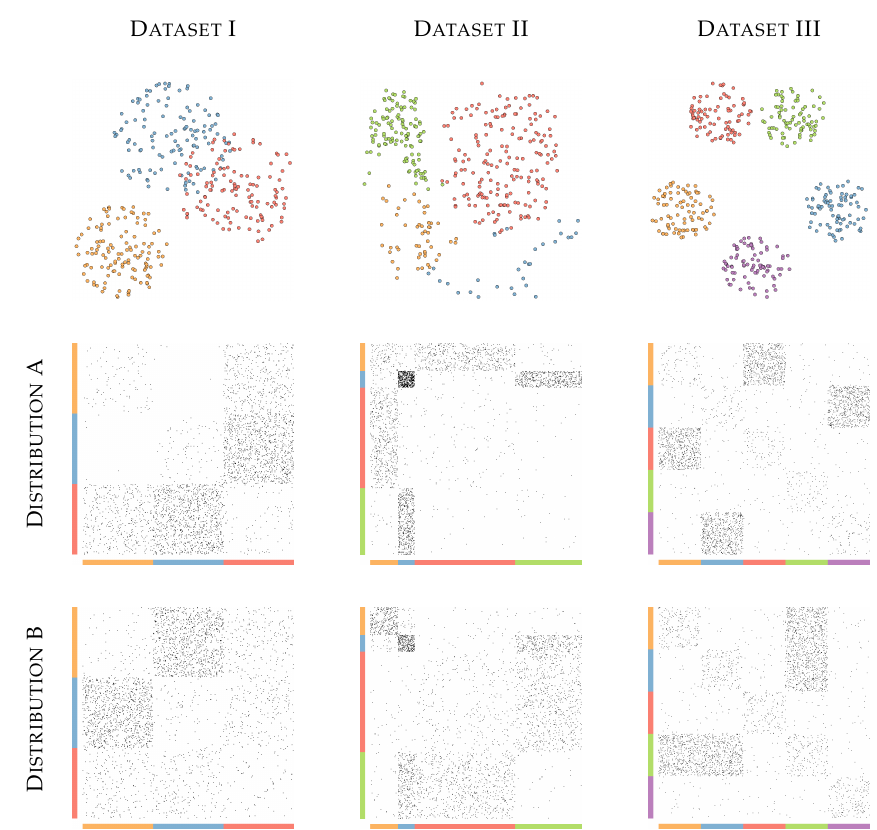
Figure 5. Scatterplots of the vertices positions and adjacency matrix visualizations of the graphs’ edges patterns used in the qualitative evaluation. Three different sets of vertices presenting different distance relationships are combine with two different edges distributions resulting in six different